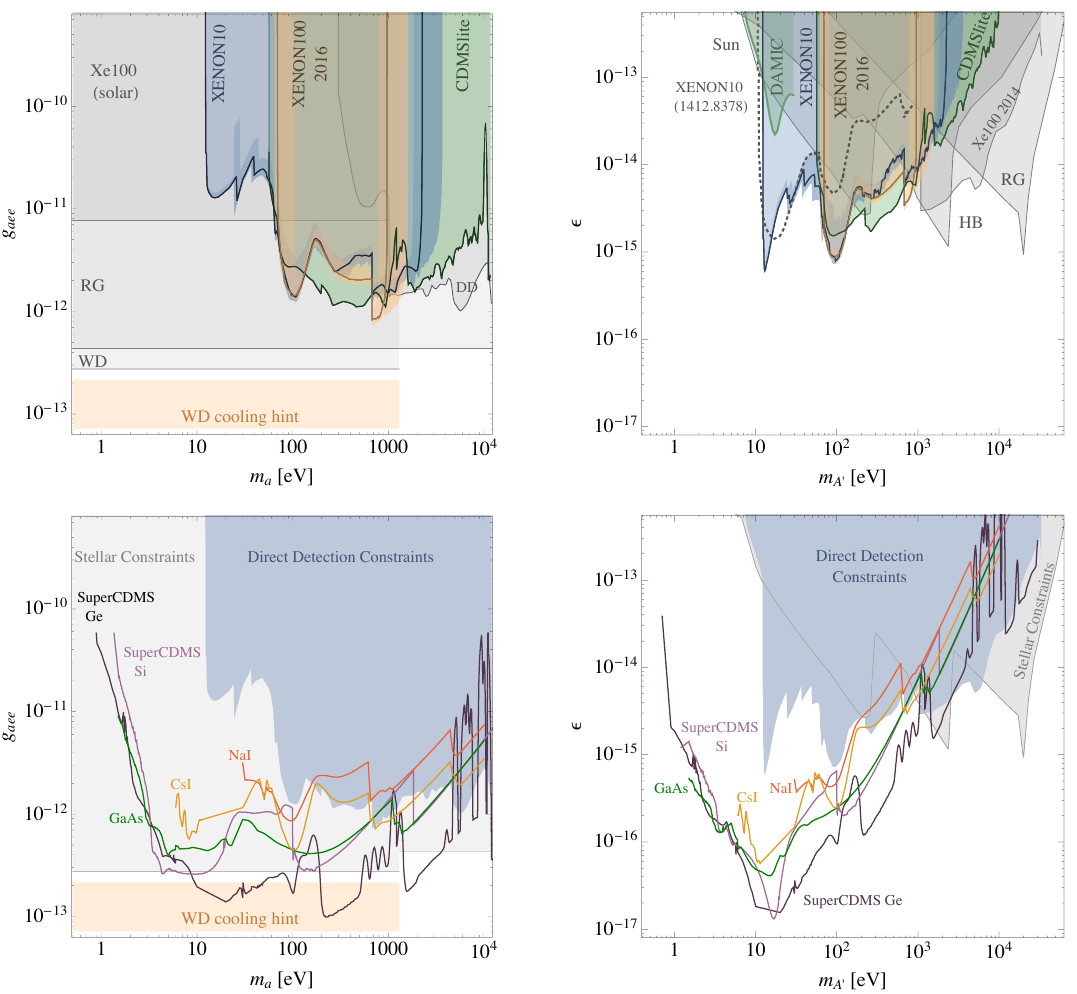
Figure 3 . Constraints ( shaded regions ) and prospective sensitivities ( solid colored lines ) for axion- like particle (ALP) dark matter ( left ) and dark-photon ( A 0 ) dark matter ( right ), assuming that the ALP/ A 0 constitutes all the dark matter. Colored regions show constraints from XENON10, XENON100, and CDMSlite, as derived in this work, as well as the DAMIC results for A 0 from [85]. Shaded bands around XENON10 and XENON100 limits show how the bound varies when changing the modeling of the secondary ionization in xenon. Deep- and light-purple solid lines show projected 90% C.L. sensitivities for SuperCDMS SNOLAB HV using either Ge (20 kg-years) or Si (10 kg- years) targets, respectively. Yellow , orange , and green solid lines show projected sensitivities for hypothetical experiments with the scintillating targets CsI, NaI, and GaAs, assuming an exposure of 10 kg-years. All projections assume a realistic background model discussed in the text, but zero dark counts to achieve sensitivity to low-energy electron recoils. In-medium e(cid:11)ects are included for all A 0 constraints and projections. Shaded gray regions show known constraints from anomalous cooling of the Sun, red giant stars (RG), white dwarf stars (WD), and/or horizontal branch stars (HB), which are independent of the ALP or A 0 relic density. Also shown ( left ) are the combined bounds from XENON100 [22], EDELWEISS [21], CDMS [20], and CoGeNT [19]; and ( right ) a bound derived in [35] based on XENON100 data from 2014 [22]. Shaded orange region in left plot is consistent with an ALP possibly explaining the white dwarf luminosity function.